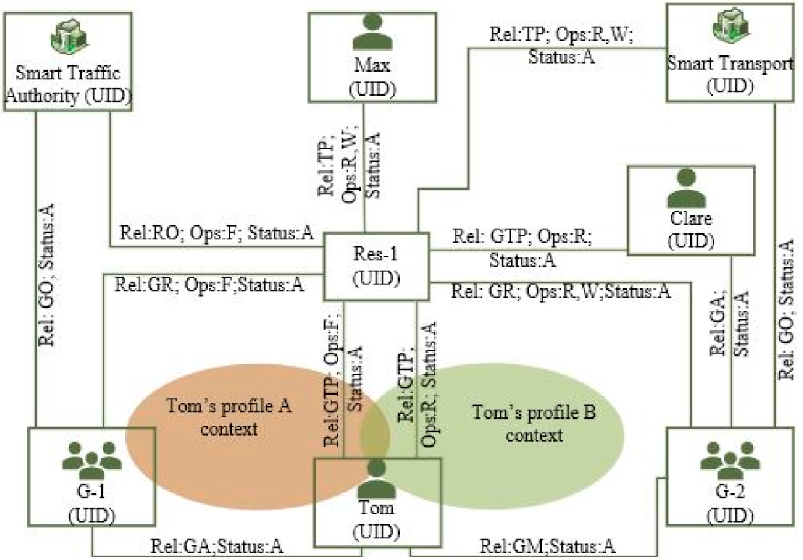
Figure 2. System model for entitlement-based AC for the given smart city use